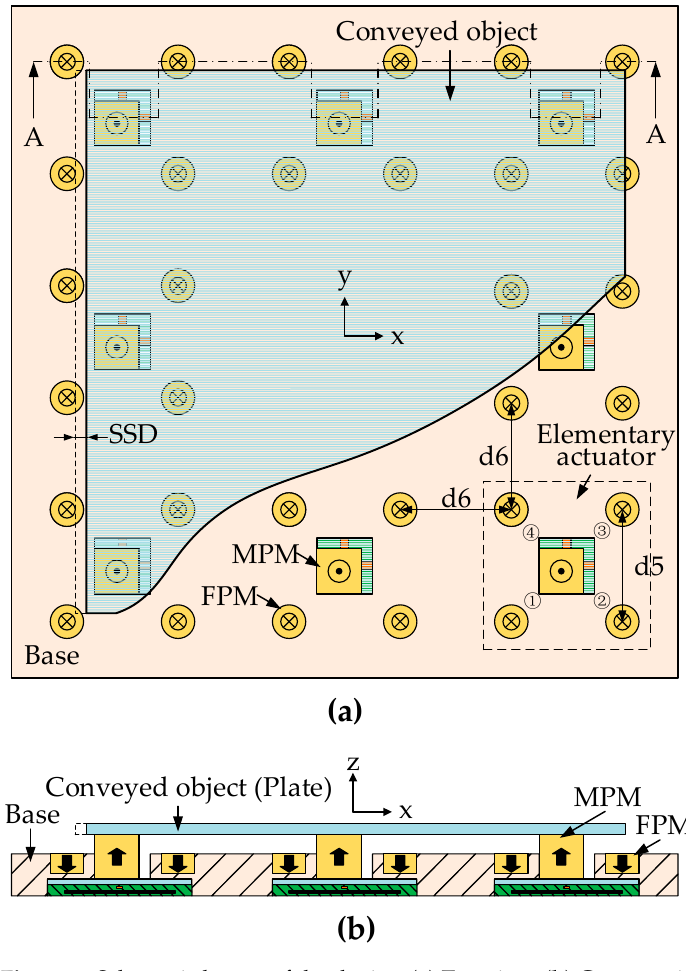
Figure 2. Schematic layout of the device. ( a ) Top view. ( b ) Cross section view A ‐ A.